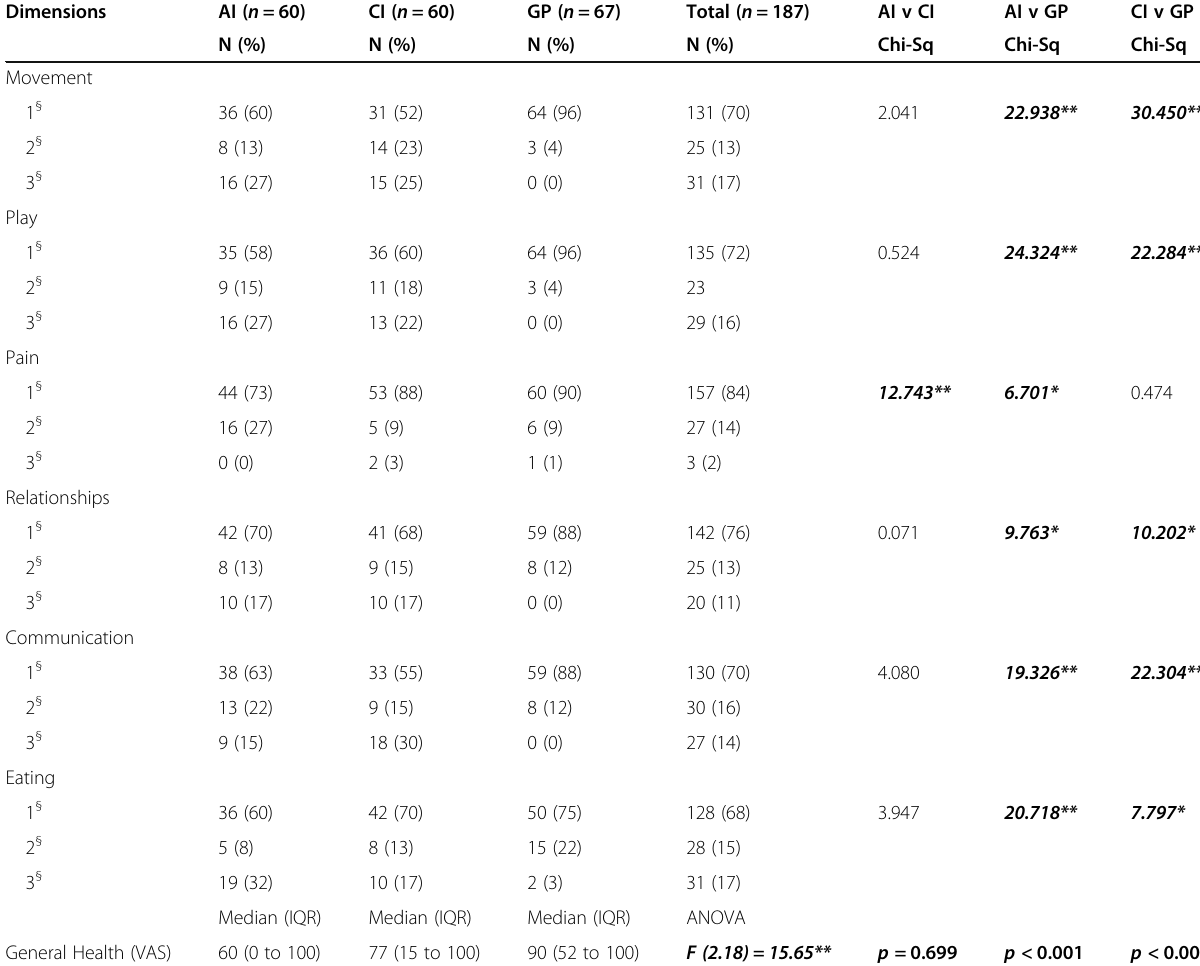
Table 3 Dimension Scores of the TANDI Across Condition Groups